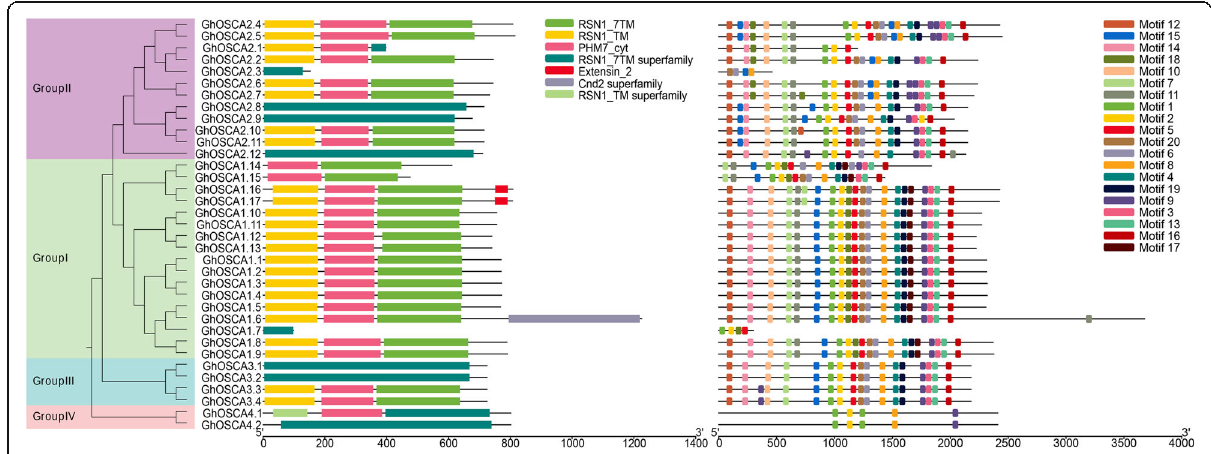
Fig. 4 The protein structure analysis of all members of OSCA gene family in G. hirsutum